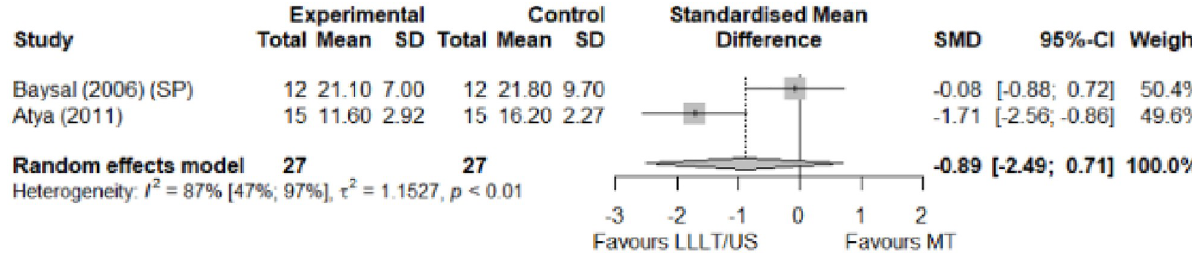
Fig 19. Analysis—Electrophysical modalities versus manual therapy (grip strength). Studies delivering modalities with a splint were marked as (SP).